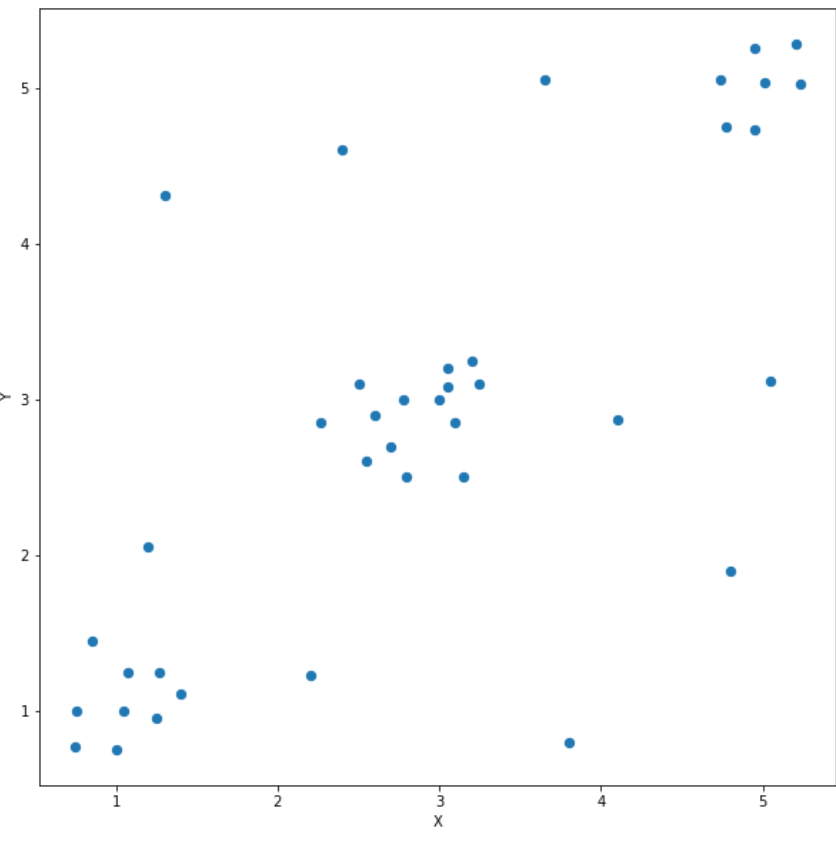
Figure 1. A simple dataset of two-dimensional